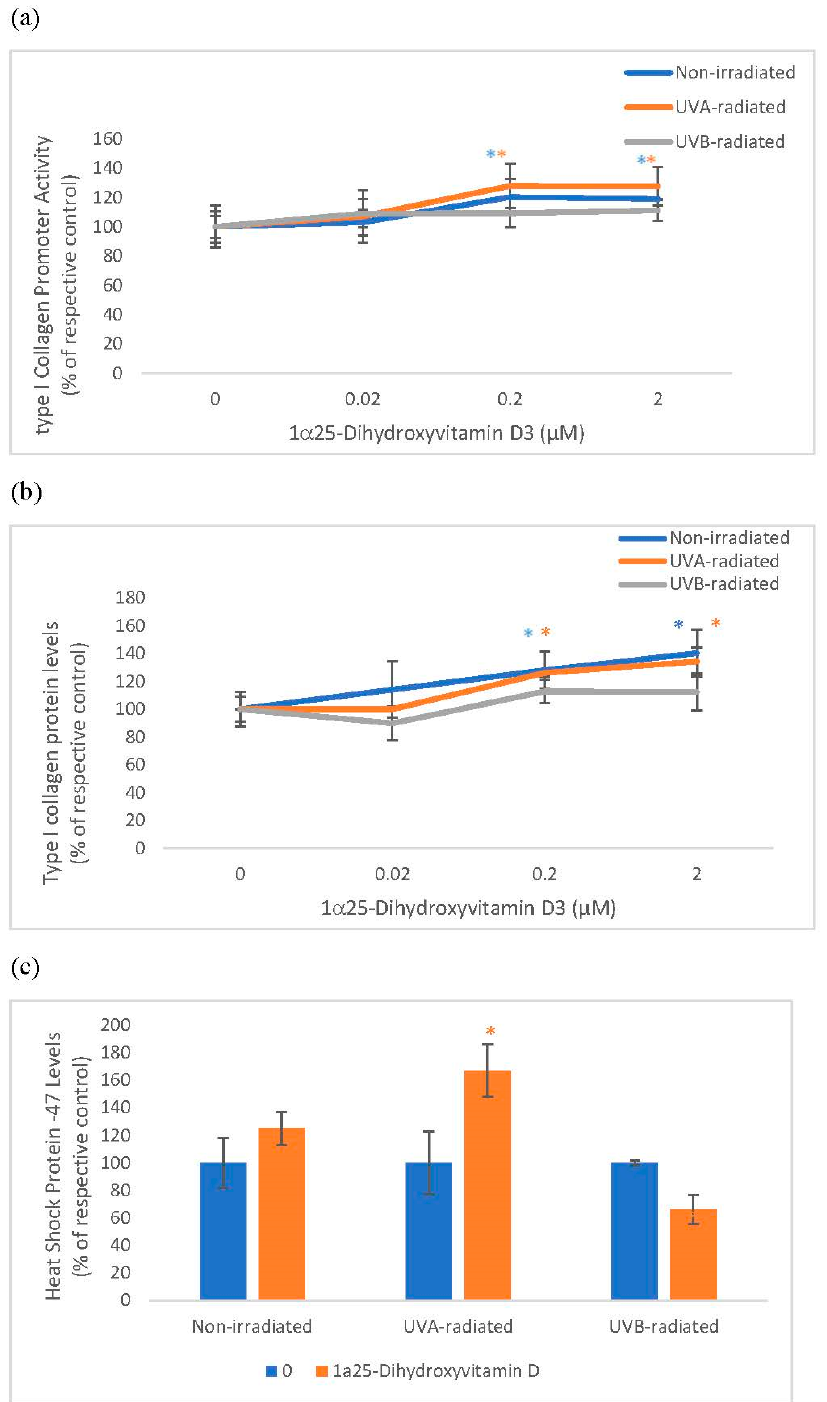
Figure 2. The effect of 1 α , 25 dihydroxyvitaminD3 (vitamin D) on type I Collagen Promoter Activity, type I Collagen Protein Levels, and Heat Shock Protein-47 (HSP-47) in non-irradiated, UVA-radiated, and UVB-radiated fibroblasts. Fibroblasts were co-transfected with COL1 α 1 promoter-firefly luciferase (pGL4 vector) and TK-hRenilla luciferase plasmids (for normalization) for 24 h, non-irradiated (blue), UVA-radiated (orange), or UVB-radiated (grey), incubated with vitamin D (0–2 µM) for 24 h, and assayed for luciferase activities (Promega, Madison, WI, USA) ( a ); and for type I collagen ( b ) and heat shock protein (HSP)-47 ( c ) protein levels by indirect ELISA (Kirkguaard and Perry Inc, Gaithersburg, MD, USA). * = p < 0.05, relative to respective controls. Error bars represent standard deviation, n =